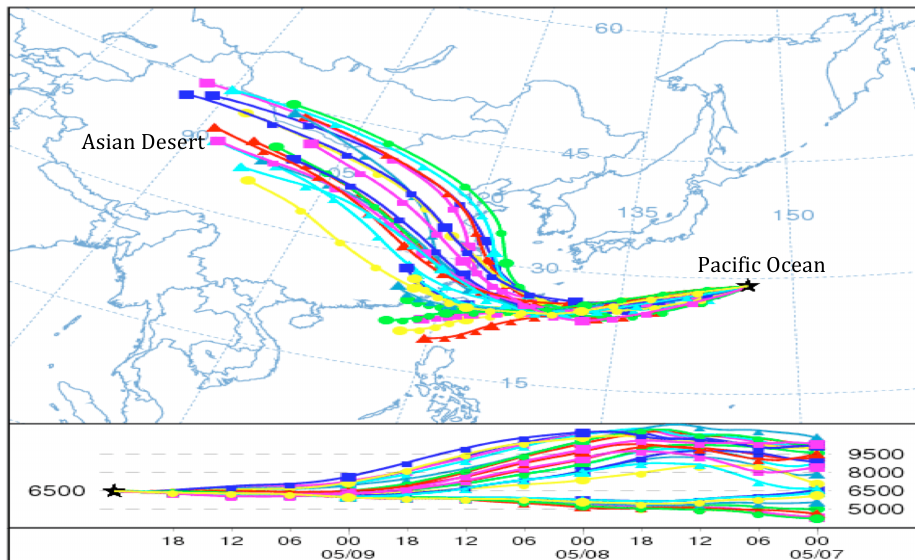
Fig. 13. Back trajectory ensemble of Asian dust for Pacific Ocean from 10 May to 7 May 2007 using HYSPLIT model for altitude 6500m. The horizontal trajectory components (top) and the vertical components (bottom) are shown in the figure. Note the back trajectory goes from right (the black star at Pacific Ocean) to left (Asian Desert) (top) and it goes from left (the black star at 6500m) to right (multiple levels) (bottom).